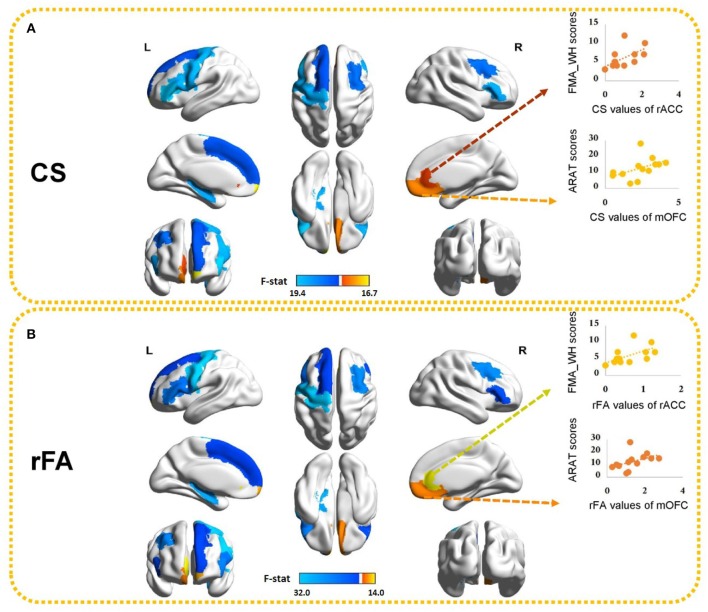
Ten brain ROIs showing significant differences in (A) CS and (B) rFA between healthy controls and stroke subjects. The values of the color bar correspond to negative logarithm of p-values from ANOVA results. Red represents higher CS/rFA values in stroke patients than those in healthy subjects and blue represents lower CS/rFA values in stroke patients than those in healthy subjects. Significant correlations between CS/rFA of the contralesional mOFC/rACC and the clinical scores are also illustrated. mOFC, medial orbitofrontal cortex; rACC, rostral anterior cingulate cortex.